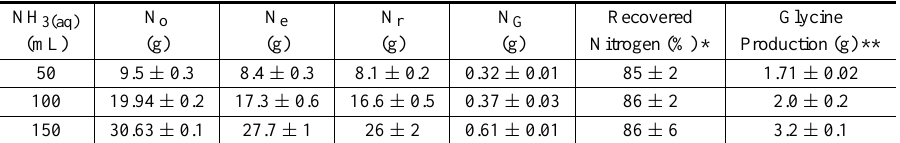
Excess nitrogen (N e ) recovery and glycine production as a function of volume of aqueous ammonia (25% m/v NH 3 (aq) solution).